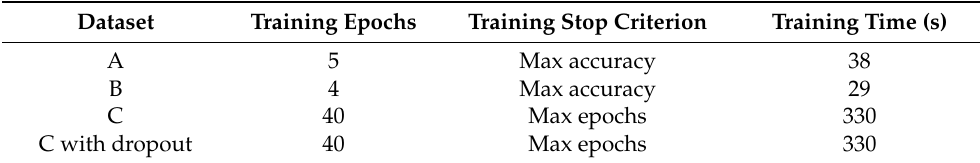
Figure 8. Fine-tuning: ( a ) dataset C; ( b ) dataset C with dropout layer. Table 4. Training epochs and training